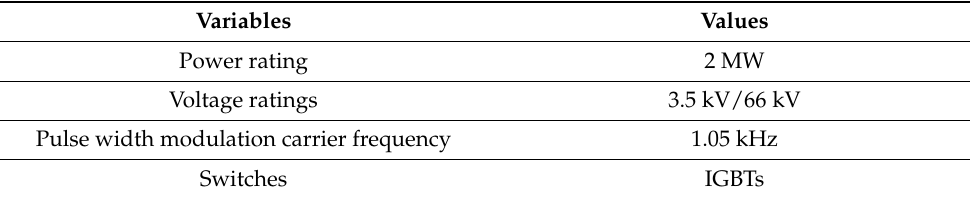
Table 2. Energy Capacitor System Parameters